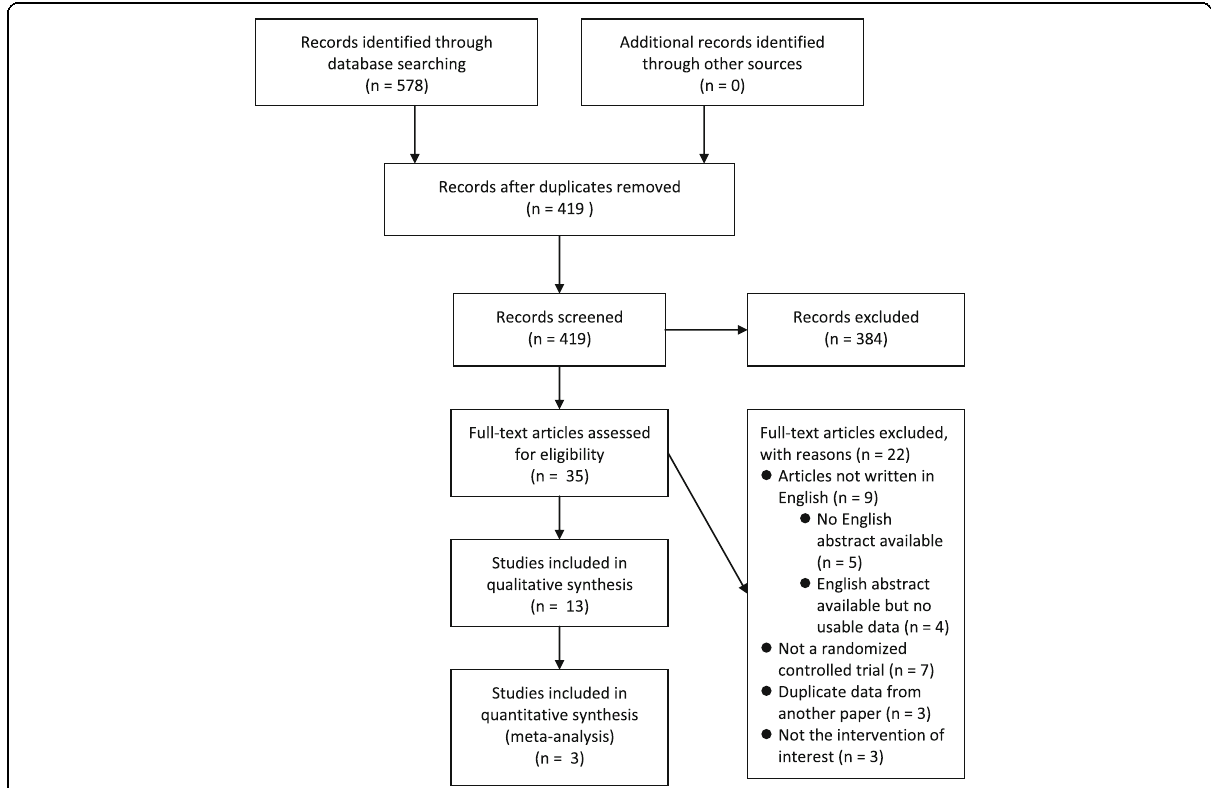
Fig. 1 PRISMA study flow